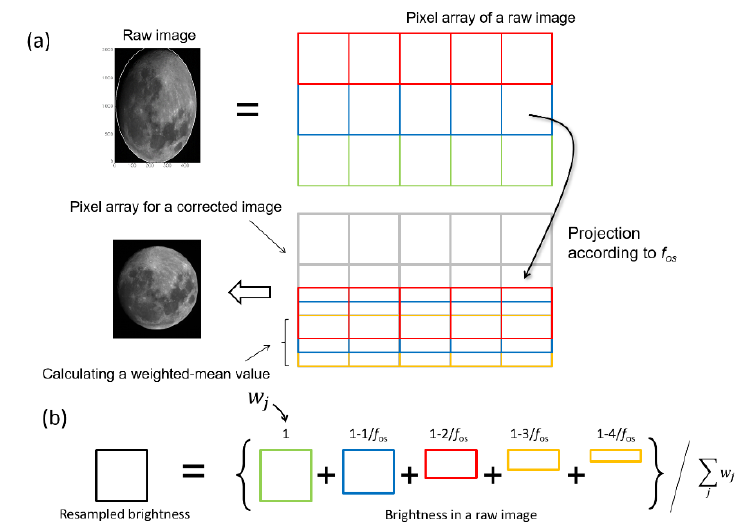
Figure A3. ( a ) Schematic view of correcting the oversampling effect for the VNIR bands in this study. ( b ) An example of calculating a weighted mean brightness for a pixel in a corrected image for the case 4 < 𝑓 𝑜𝑠 < 5. Note that the distributions of 𝑤 𝑗 are different for different lines in the corrected image due to the non-integer 𝑓 𝑜𝑠 .